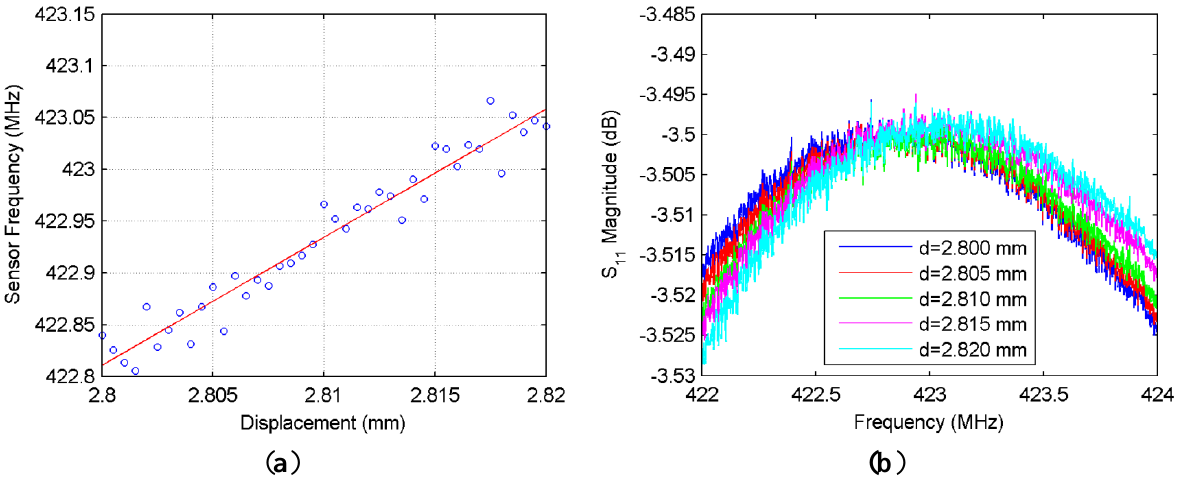
Figure 5. ( a ) Displacement sensor frequency shift versus a displacement range of 20 µm with 0.5 µm steps shown along with a linear fit; ( b ) S frequency peaks which are plotted in (a) for different displacement levels,